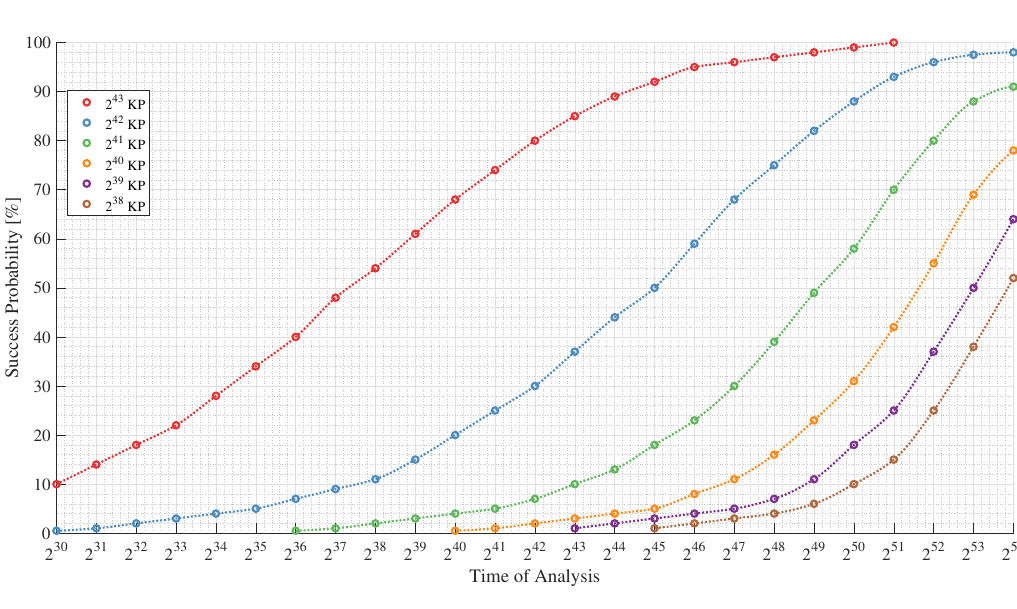
Figure 17: Success Probability of Linear Cryptanalysis by Known Plaintexts and Time of